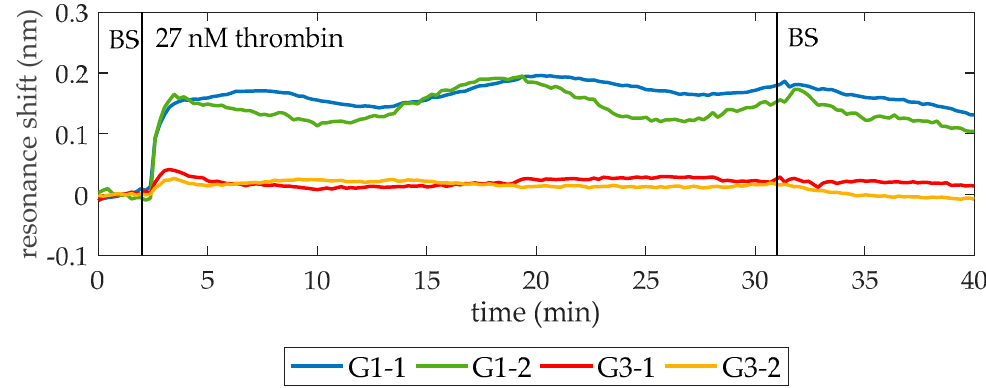
Figure 5. Sensing response obtained when flowing a 27 nM thrombin solution over a photonic chip where only half of their PC structures have TBA on their surface (G1-1 and G1-2). Only the PBG edges of such PC structures experience an average shift of 119 pm, whereas control PC structures (G3-1 and G3-2, without TBA) do not experience any sensing change. This confirms the recognition specificity. Regarding the instability of G1-1 and G1-2 while thrombin is flowed, it is again attributed to fluidic irregularities.